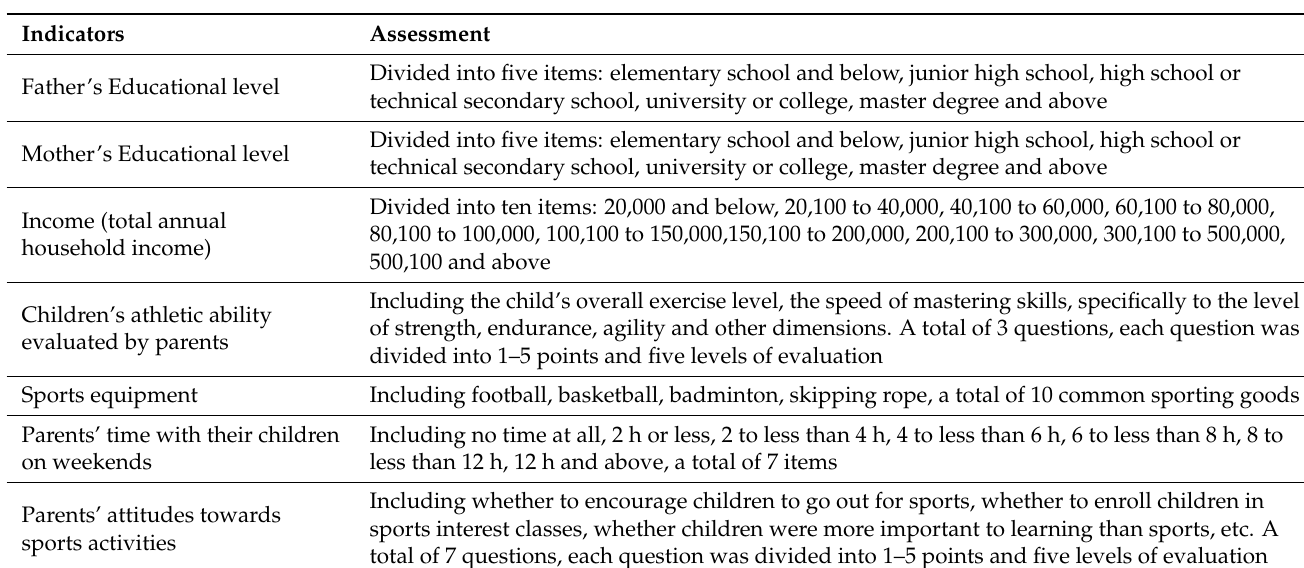
Table A1. Specific index content and evaluation